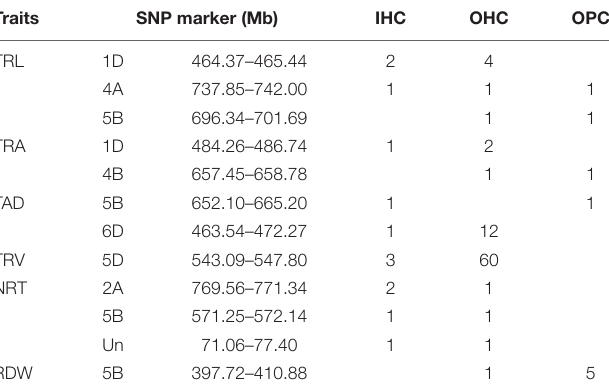
TABLE 6 | Summary of co-localization regions for root traits by